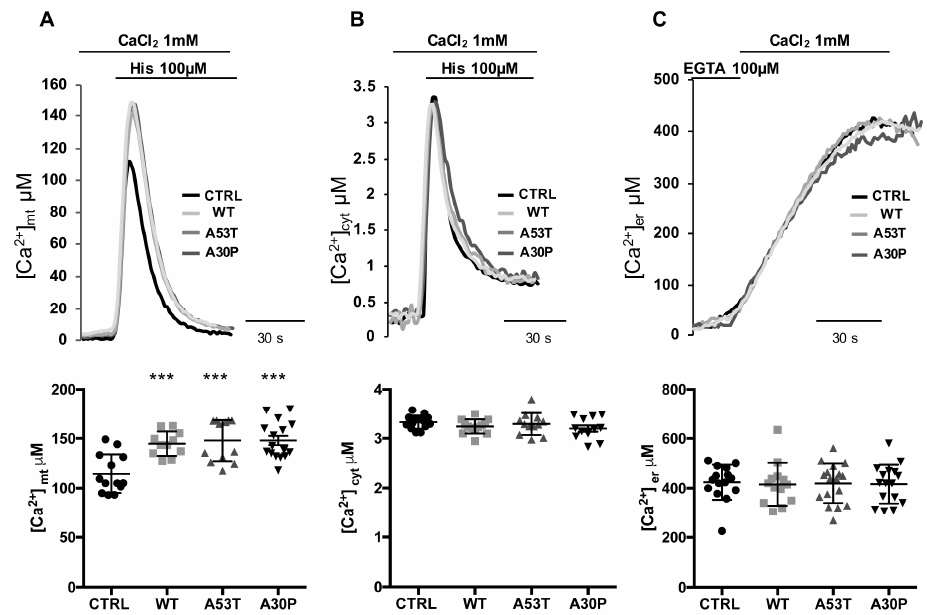
Figure 2. Overexpression of A53T and A30P α -synuclein mutants enhances mitochondrial Ca 2 +